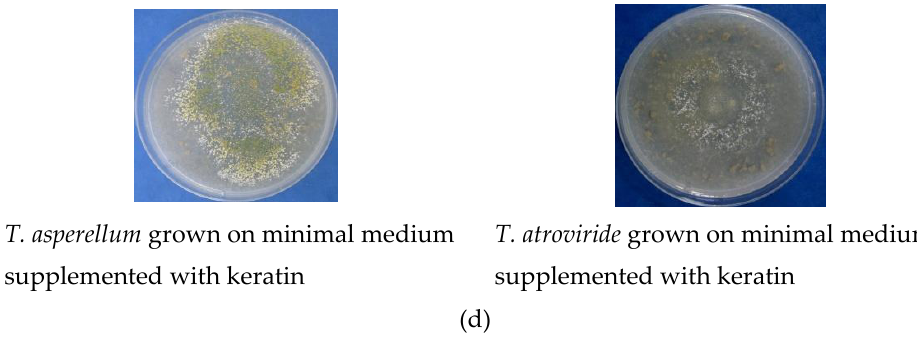
Figure 2. Enzymatic activities of Trichoderma isolates expressed on agar media supplemented with specific substrate. ( a ) Trichoderma pure cultures on PDA medium. ( b ) Colored zone generated by Trichoderma isolates for chitinase activity on medium supplemented with colloidal chitin. ( c ) Cellulase activity expressed on medium supplemented with carboxymethylcellulose CMC. ( d ) Keratinase activity expressed on specific medium.